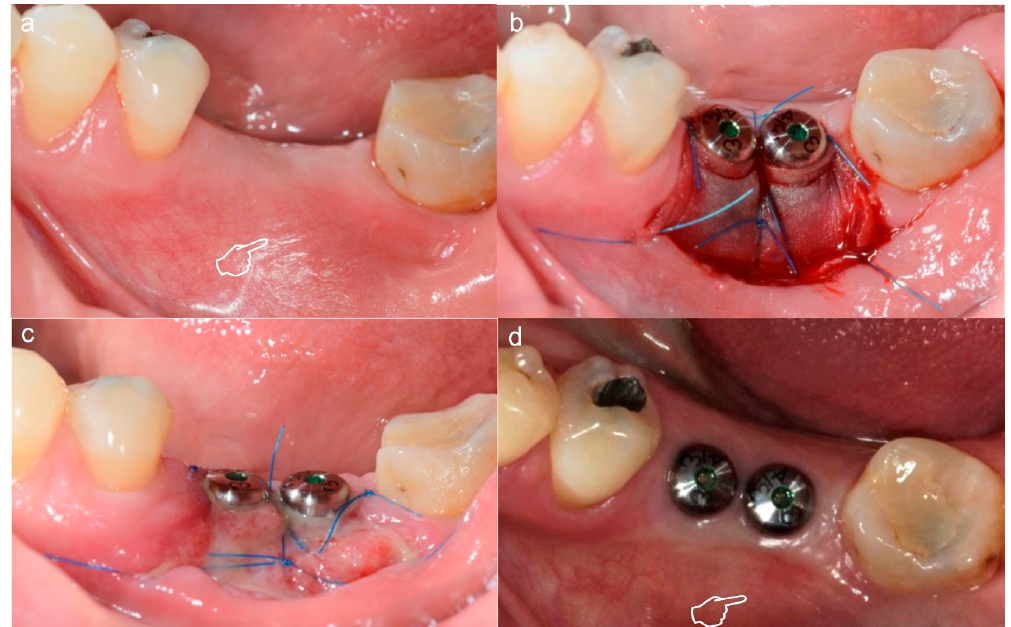
Figure 6. Soft tissue augmentation in an implants’ second stage surgery using Mucograft. ( a ) Prior surgery ( b ) Post-surgery with the matrix fixed to the recipient bed ( c ) 2 weeks follow-up ( d ) 3 months follow-up. This matrix was used as contouring of soft tissue around dental implants. The reduced ridge (pointer in ( a )) was thickened after soft tissue augmentation (pointer in ( d )).